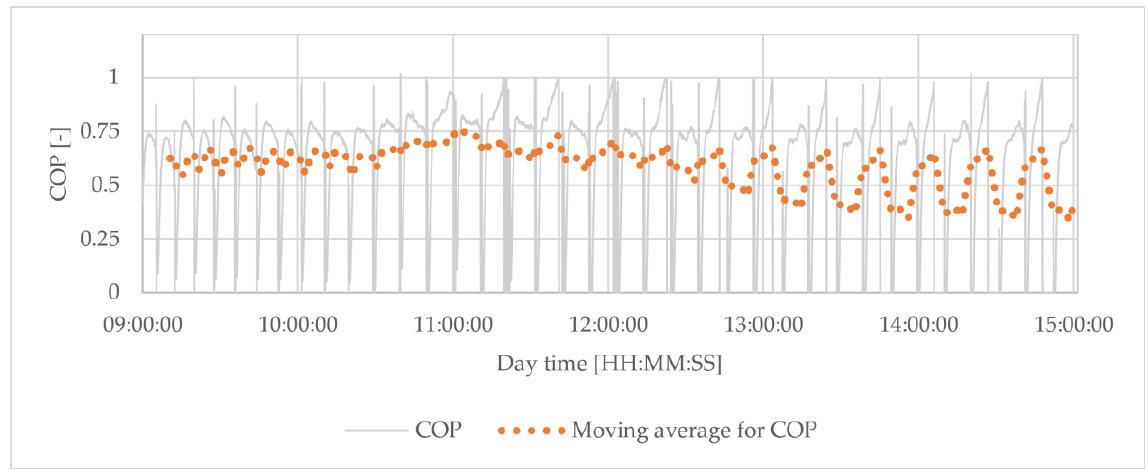
Figure 9. Measured values of temperatures and flow rates over time for 8th July. 3.1. Measurements for Non-Standard Modes of Chiller Operation for July For selected time intervals (9 a.m. to 3 p.m.), graphs of changes in water mass flow rates in the heating and chilled water circuits were drawn up for each day. In addition, the temperature parameters of the hot and chilled water were presented (Figures 9 and 12). In addition, the COP (Figures 11 and 14) and the heating power demand and chilled water production during the time under consideration were calculated from the measure- ments as shown in Figures 10 and 13. When analysing the data in Figure 9, it should be concluded that the chilled water flow rate is approximately constant at 0.474 kg/s, with possible fluctuations of the order of 10 −3 kg/s. The periodic, sudden and short increases and decreases in the flow rate are related to the switching of the chiller cycles. The hot water flow rate, in turn, remains at 0.512 kg/s and is subject to cyclic fluctuations of approx. 0.3 kg/s, which, as in the case of chilled water, is related to the cycling of the adsorption chiller operation. It should be noted that the hot water flow rate between 12 noon and 1 p.m. deviates significantly from that observed during the other hours of operation and does not resemble that recorded